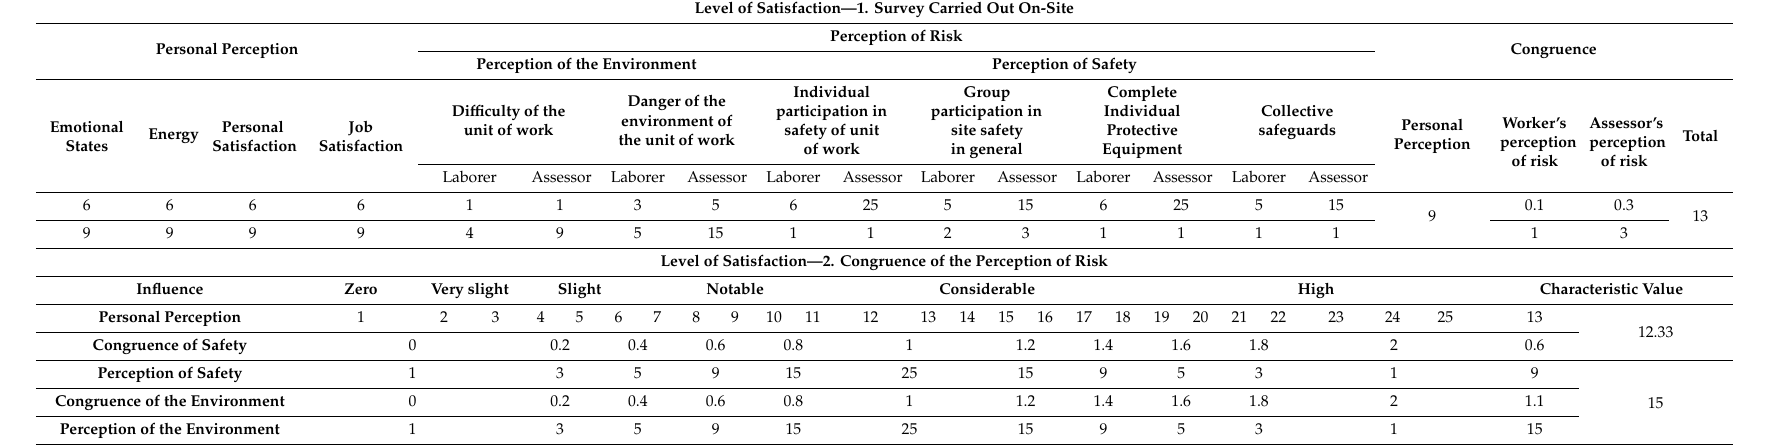
Table 9. Example of characteristic value in the level of satisfaction. Survey and